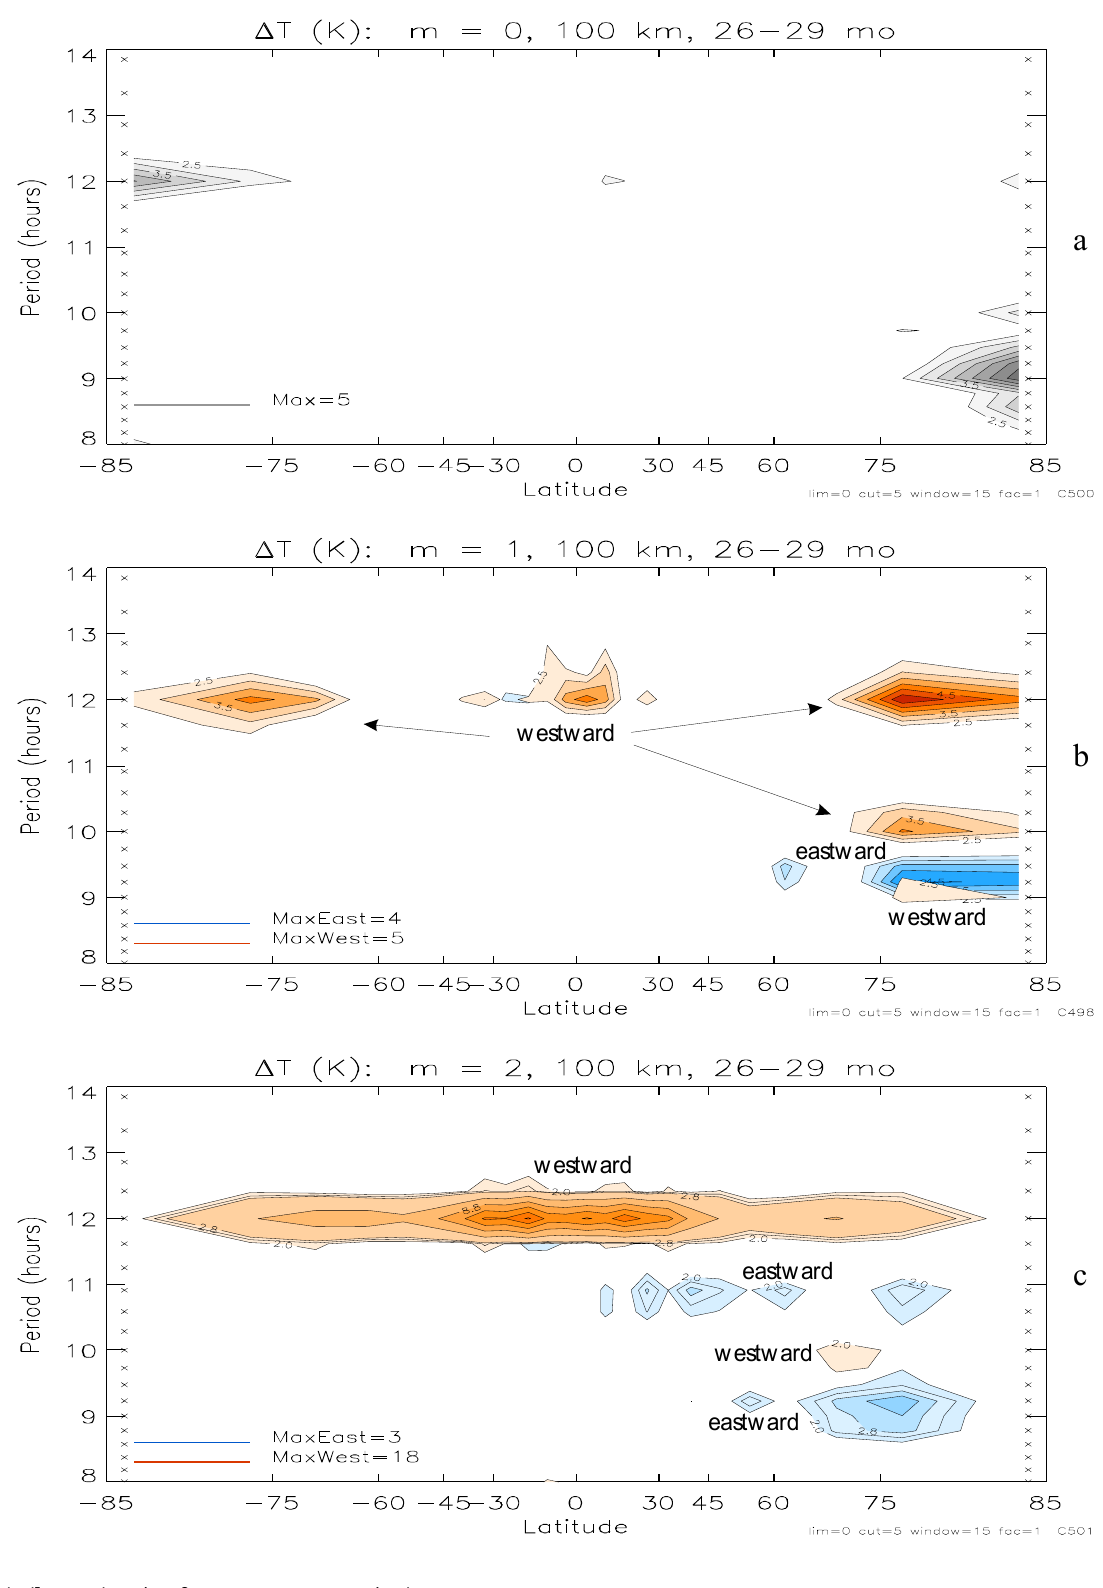
Fig. 6. Similar to Fig. 5 but for temperature